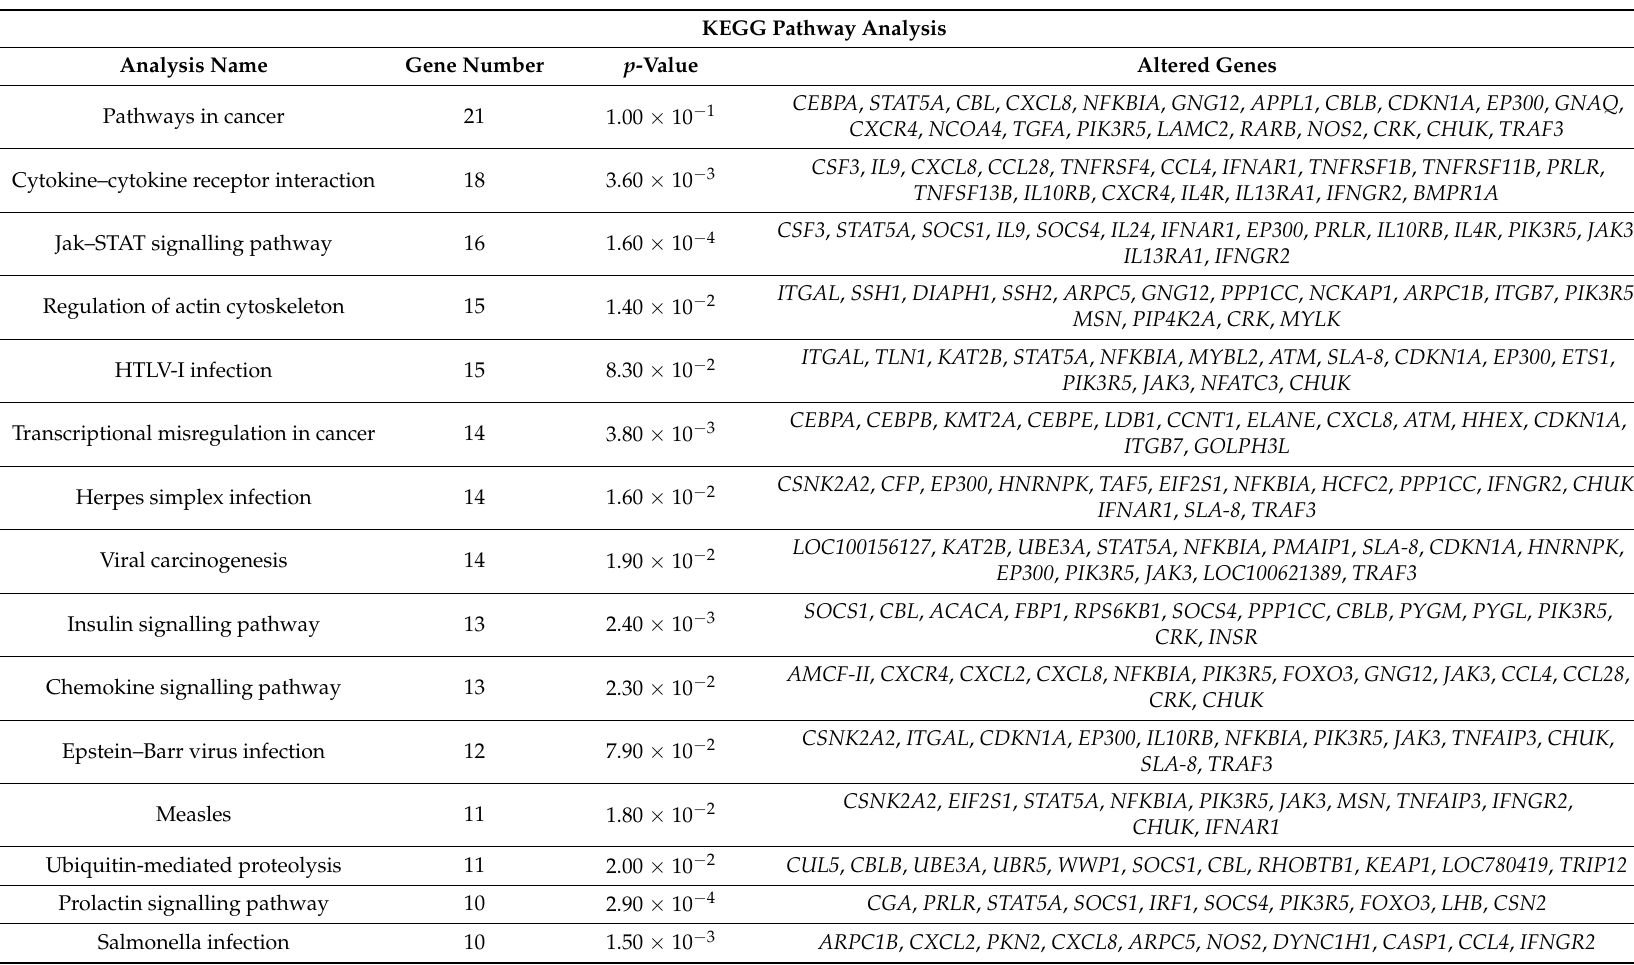
Table 1. Analysis of pathways significantly enriched in the list of differentially expressed